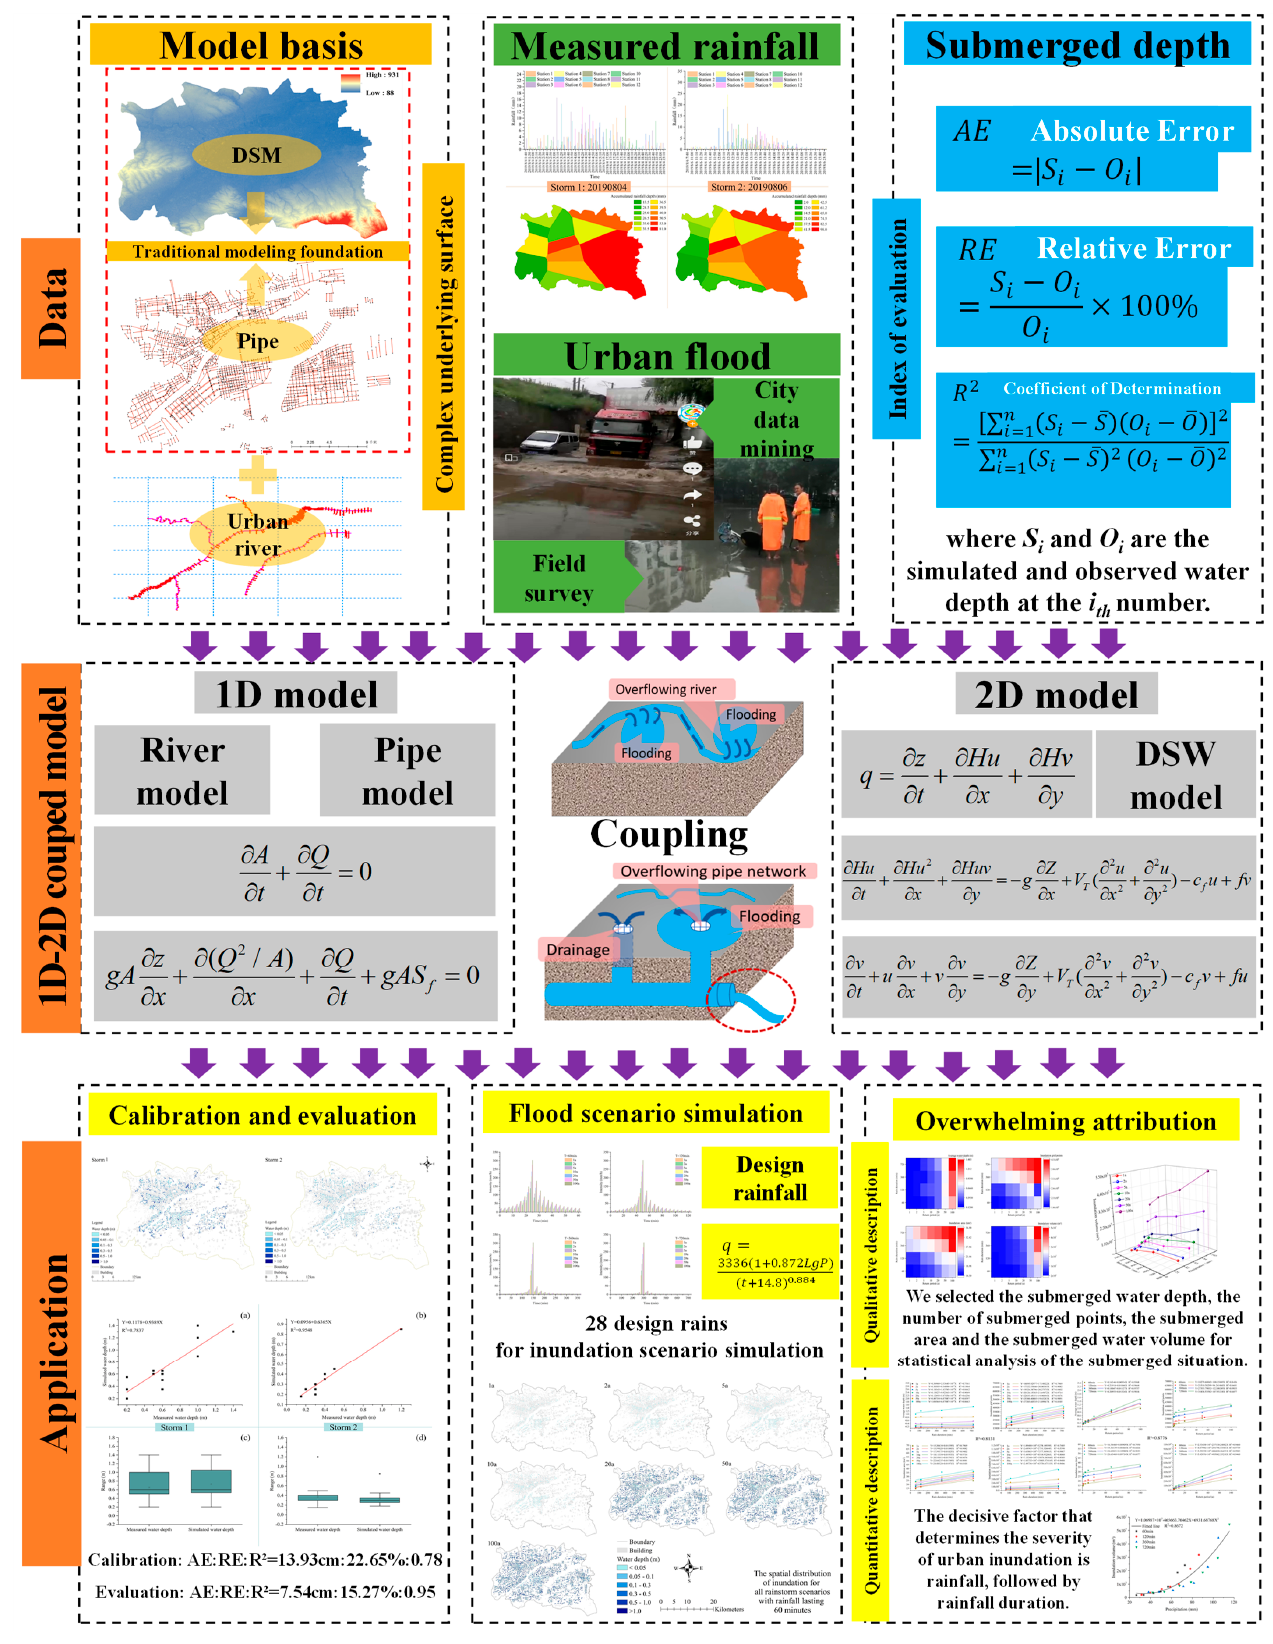
Figure 5. 1D–2D rainfall flood model coupling scheme (The process frame diagram of this study).